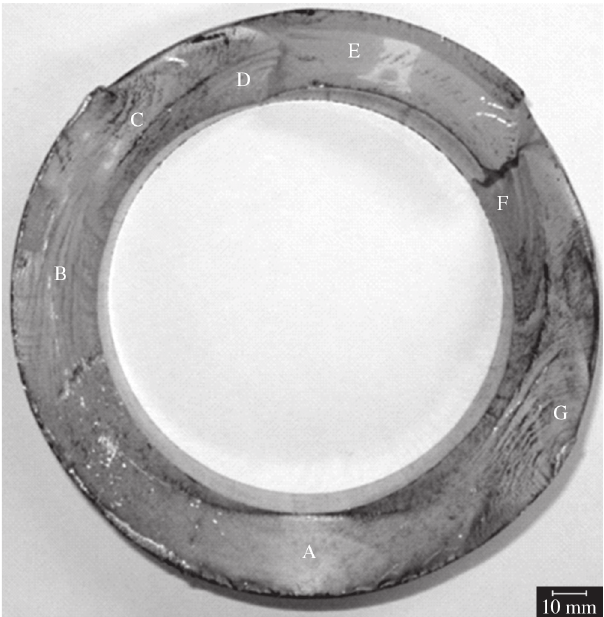
Figure 12. Visual inspection of drill pipe DPA03.